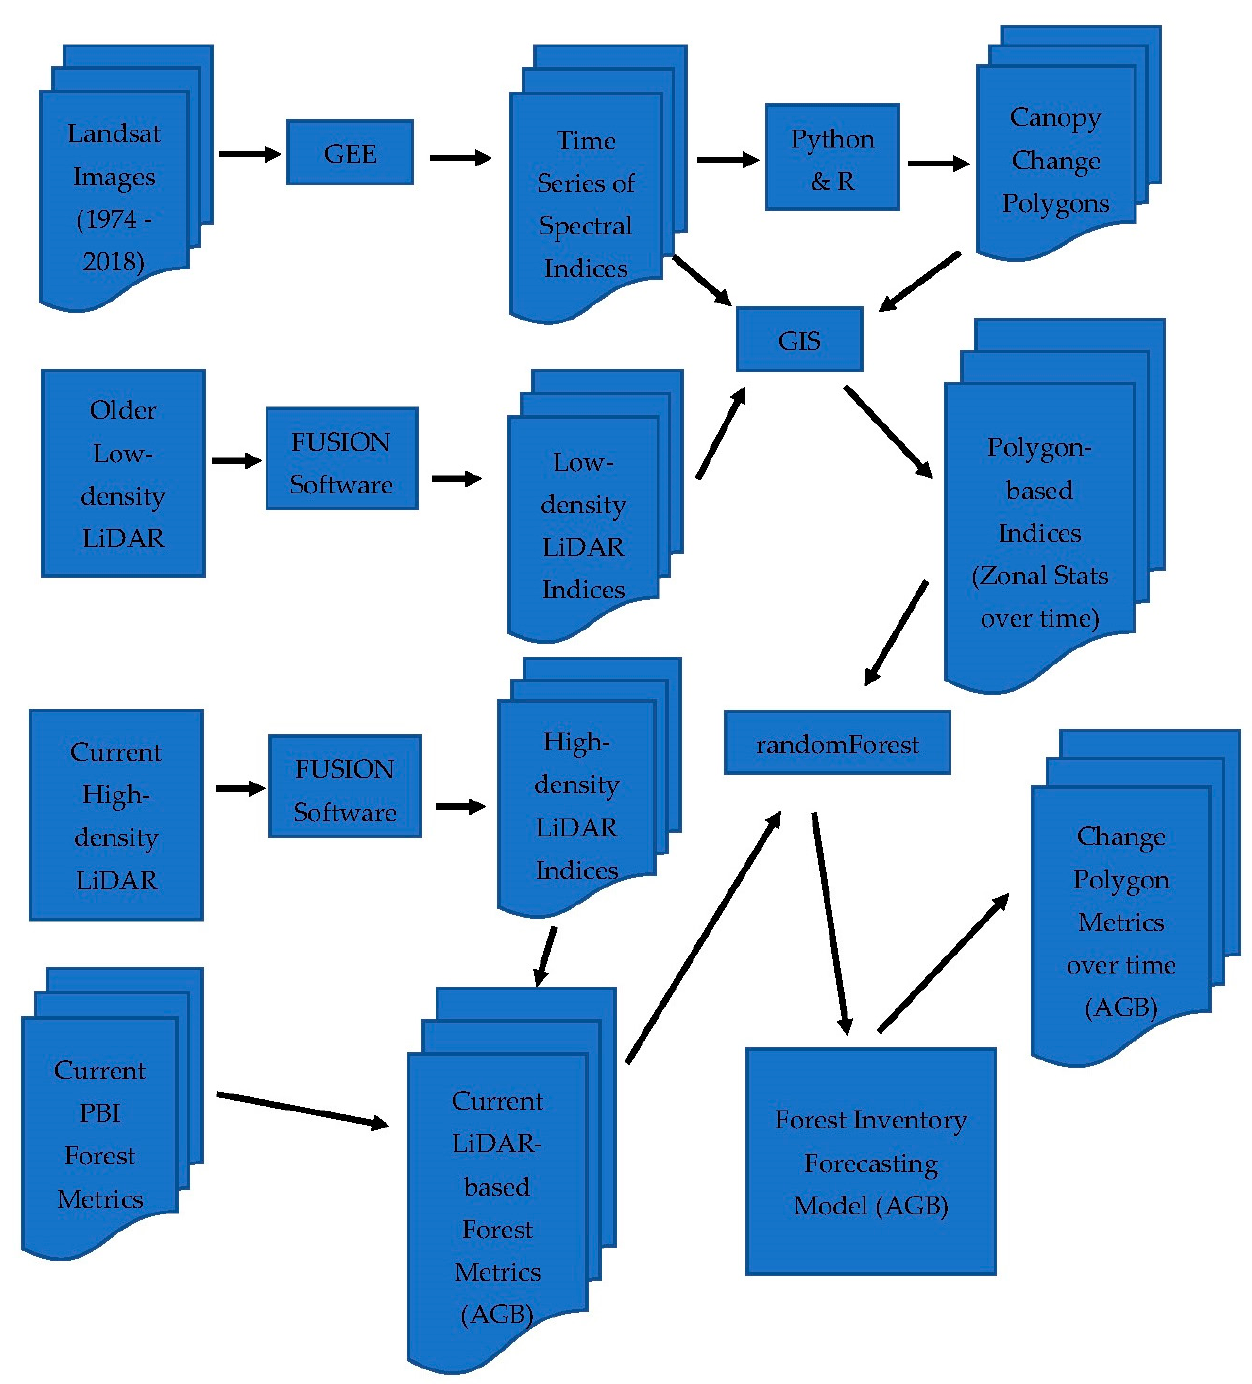
Figure 2. Flowchart of data management and model development process.